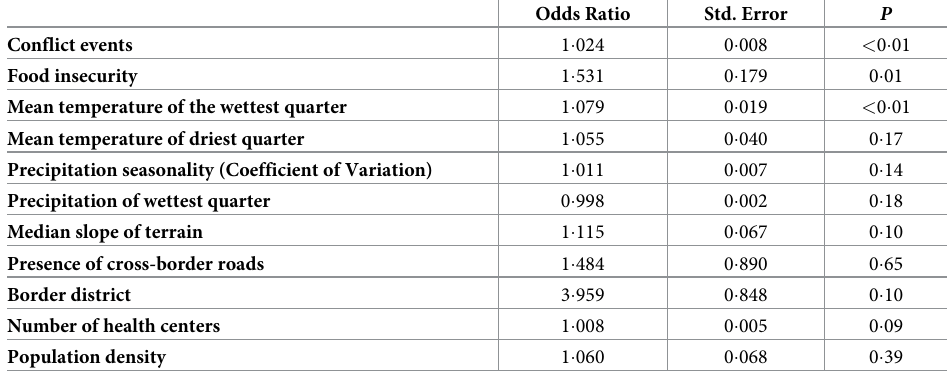
Odds Ratio Std. Error P